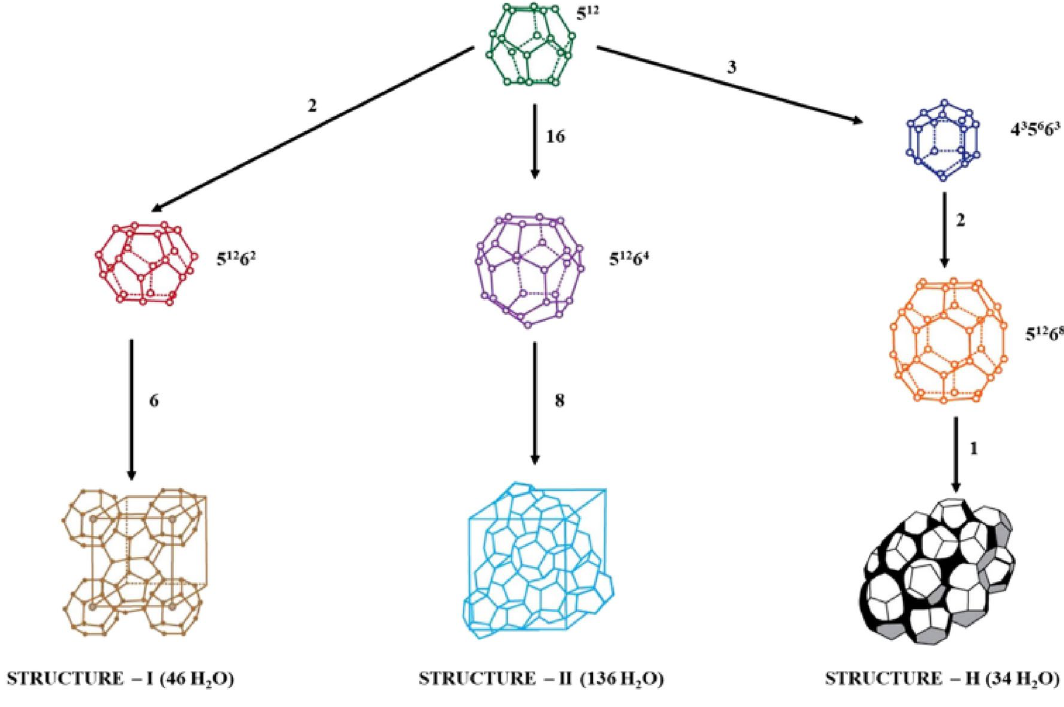
Figure 2. Standard structures of gas hydrates (sI, sII, sH) 17